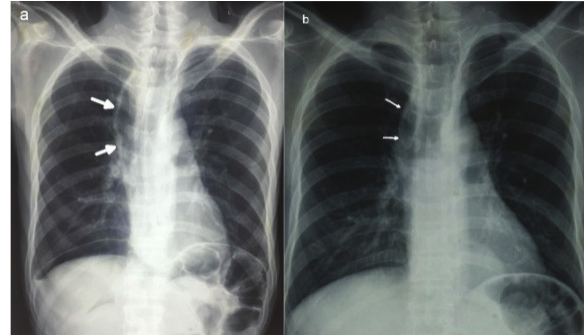
Figure 3. Follow-up chest radiograph, immediate (a) and at three months (b) visit showing residual esophageal dilatation